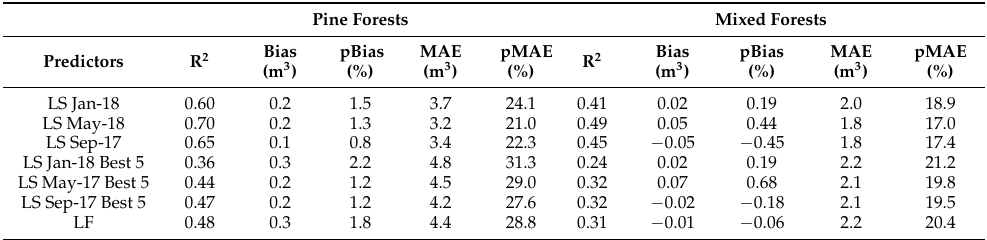
Table 2. Summary of model performance with separate Landsat and LANDIRE predictors. LS indi- cates Landsat-based predictors at specified date, Best 5 indicates best five Landsat-based predictors according to estimated variable importance, LF indicates LANDFIRE-based predictors. The hold-out test sample size was 2269 and 2226 for pines and mixed forests, respectively.